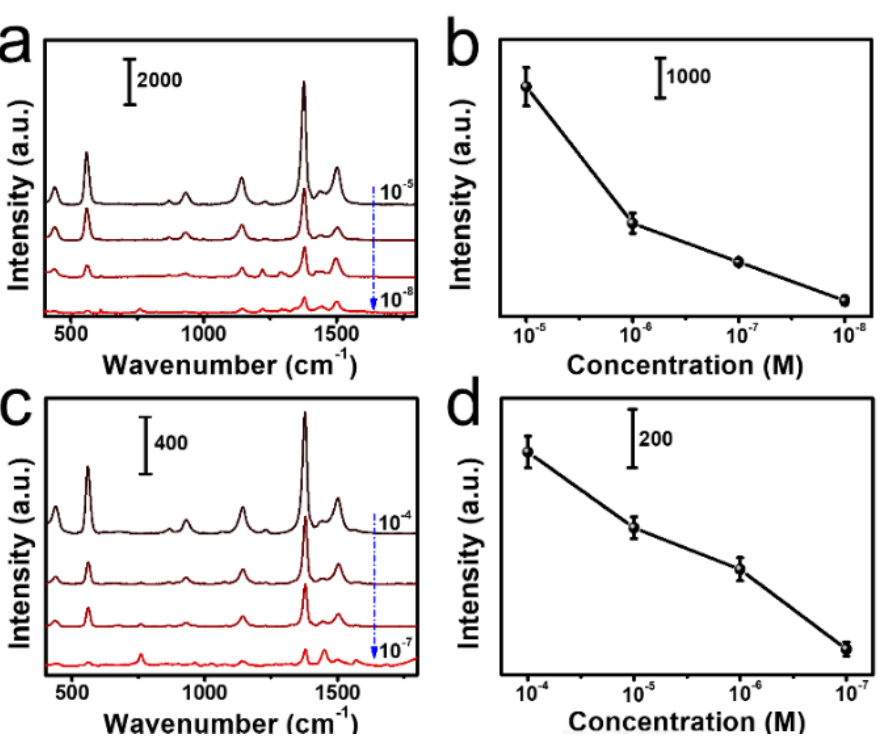
Figure 5. The SERS detection of thiram. ( a , c ) SERS spectra of thiram in acetone or orange juice. ( b , d ) Plot of concentration-SERS intensity relationship of the 1377 cm −1 band.